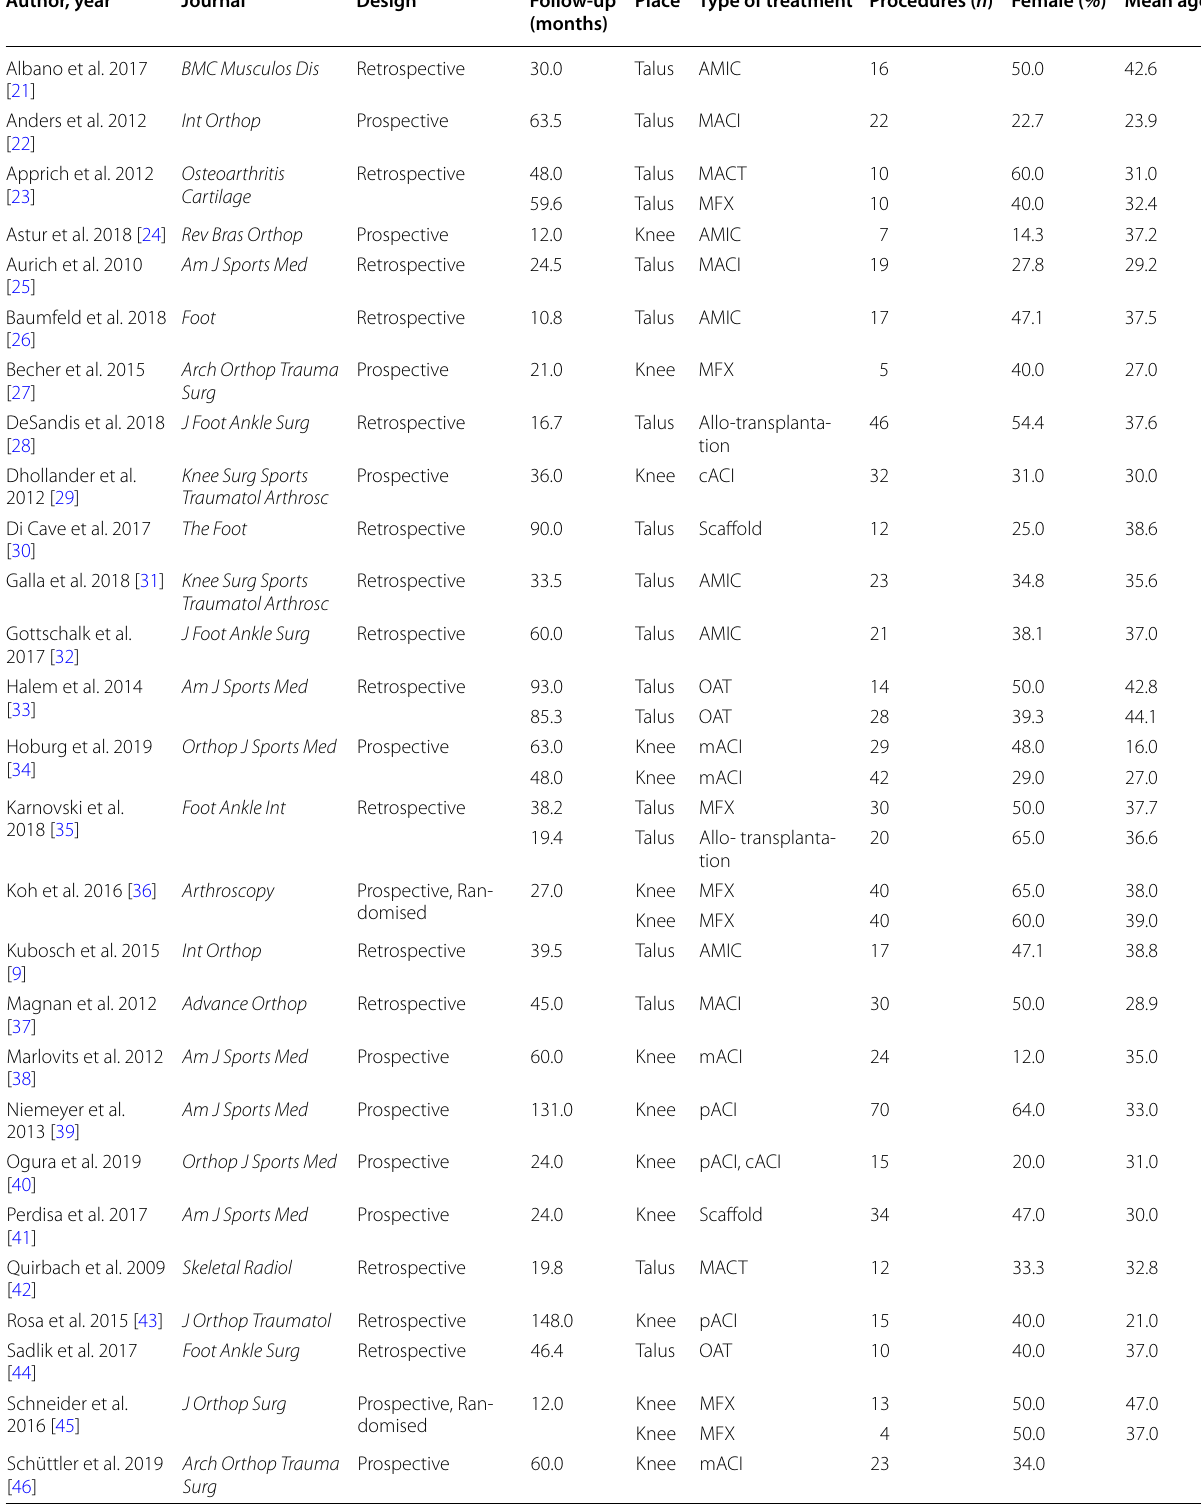
Table 1 Generalities and patients baseline of the included studies Author,